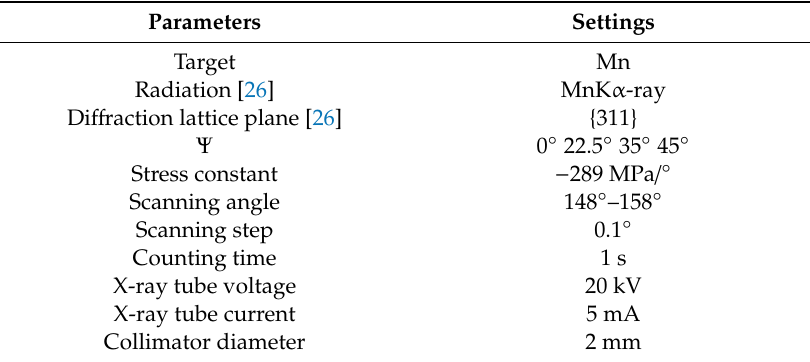
Table 2. Main parameters of X-ray di ff raction (XRD)